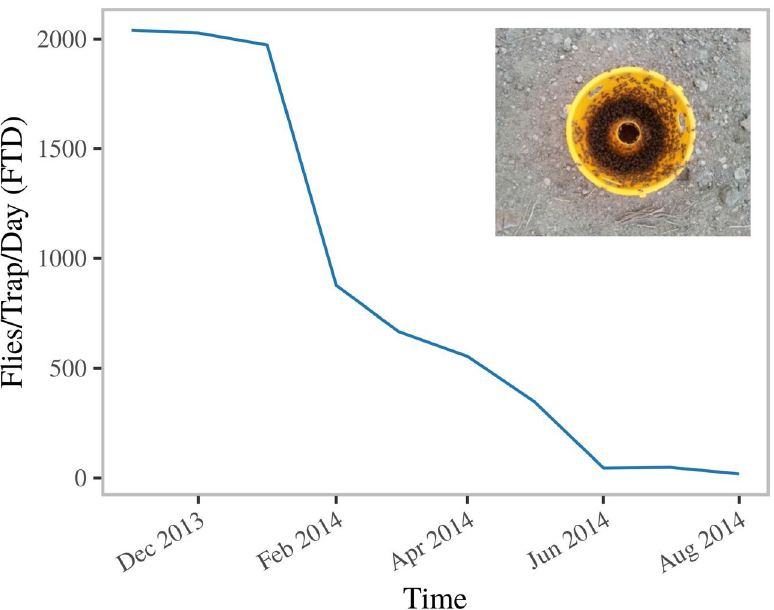
Figure 1. Effect of male lures, bait sprays and orchard sanitation on the B. dorsalis trap catches with methyl- eugenol baited traps from November 2013 to August 2014 in a large-scale farm. The inset illustrates a 30 min trap capture of a methyl eugenol trap placed 10 m outside the guava orchard prior to intervention (September